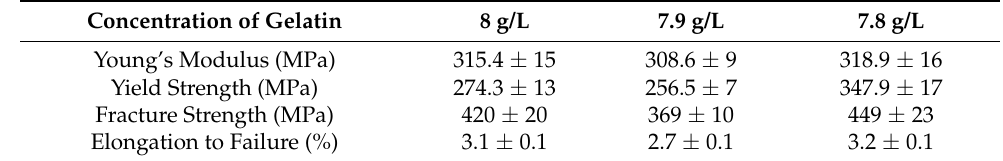
Figure 5. Stress–strain curves of the nt-Cu films electroplated with the Cu-sulfate base plating solution added with the concentration of gelatin (0 g/L), (8 g/L), (7.9 g/L), and (7.8 g/L), respectively. Table 3. The Young’s modulus, yield strength, fracture strength, and elongation to failure for the nt-Cu films plated with the concentration of gelatin (8 g/L), (7.9 g/L), and (7.8 g/L).